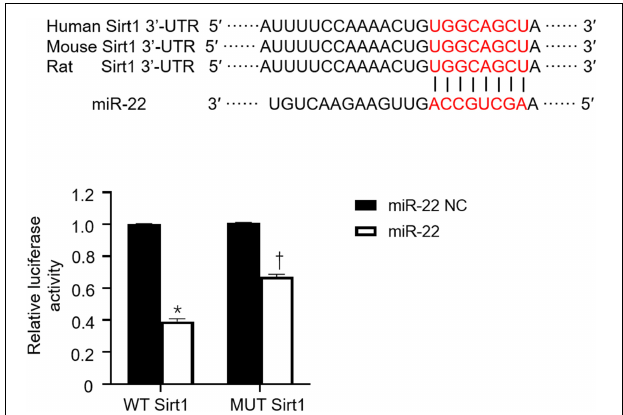
FIGURE 3 | miR-22 exerted its effect during septic cardiomyopathy by targeting sirt1. Results of luciferase report. * P < 0.05 vs. NC group in sirt1 group; † P < 0.05 vs. NC group in MUT sirt1 group. All the experiments were repeated three